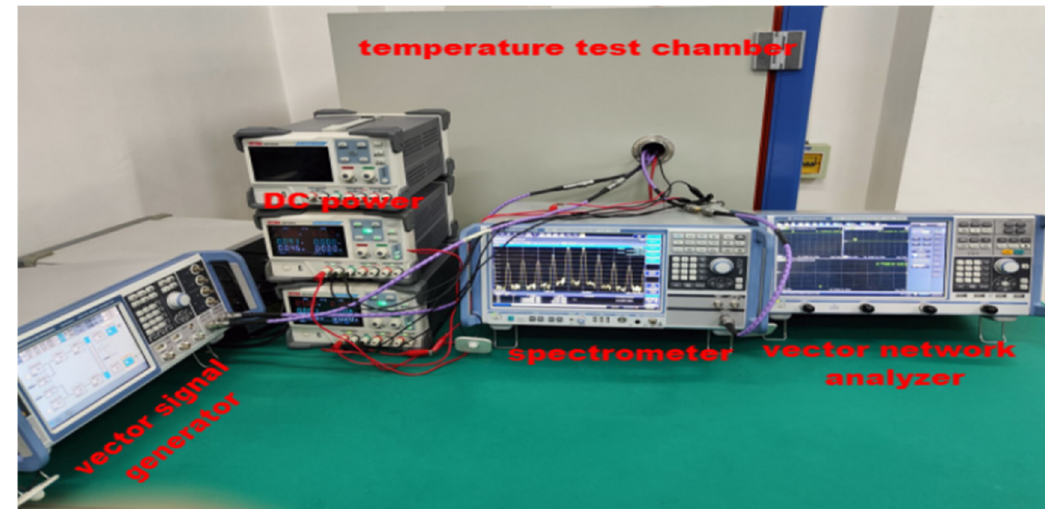
Figure 7. Measurement circuits of MMIC PA.